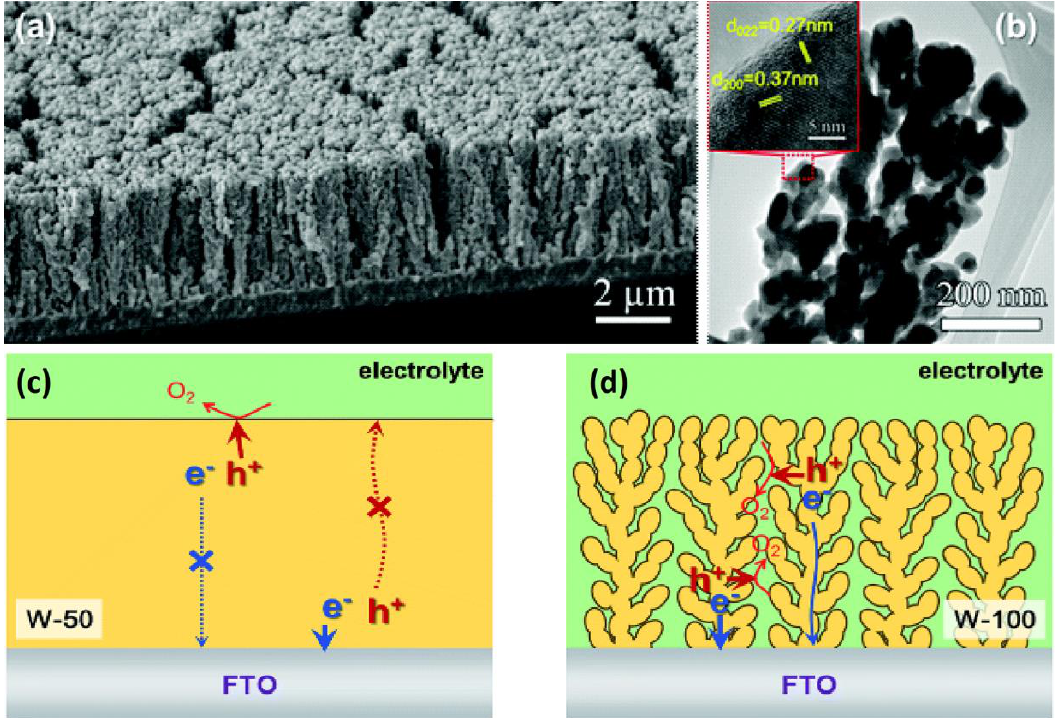
Figure 10 . Figure 10. ( a ) SEM image of the WO 3 photoanode; ( b ) TEM image of the nanoporous WO 3 clusters,